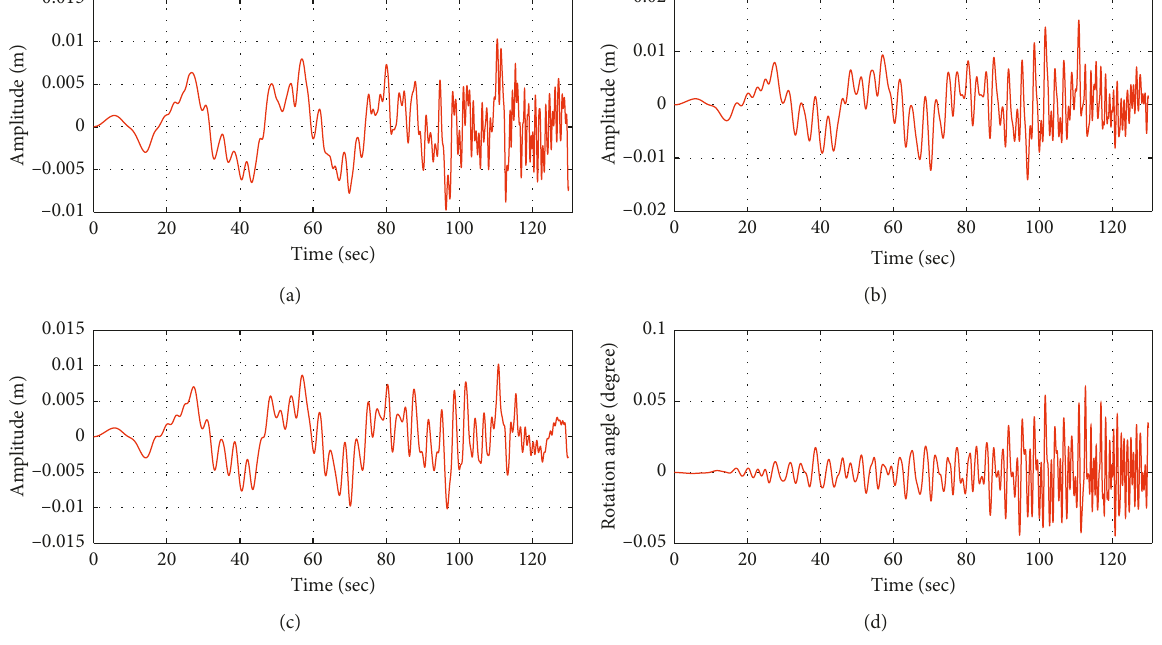
Figure 11: Transverse vibration at (a) connecting point A (shown in Figure 1), (b) connecting point B (shown in Figure 1), and the (c) conveyance. Plot (d) shows the rotation at the